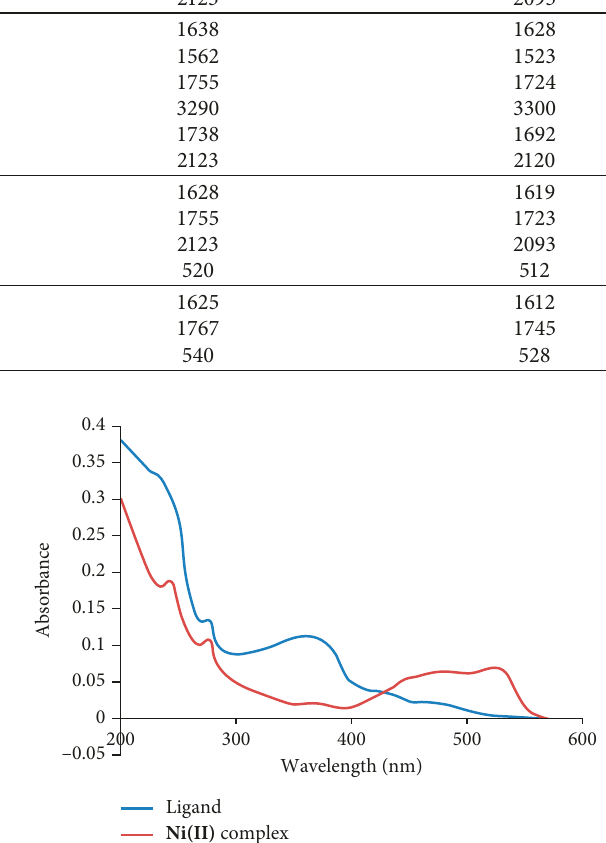
Figure 1: The electronic spectra of the free β -diketimine Schiff base ligand and the related Ni(II) complexes in CH 2 Cl 2